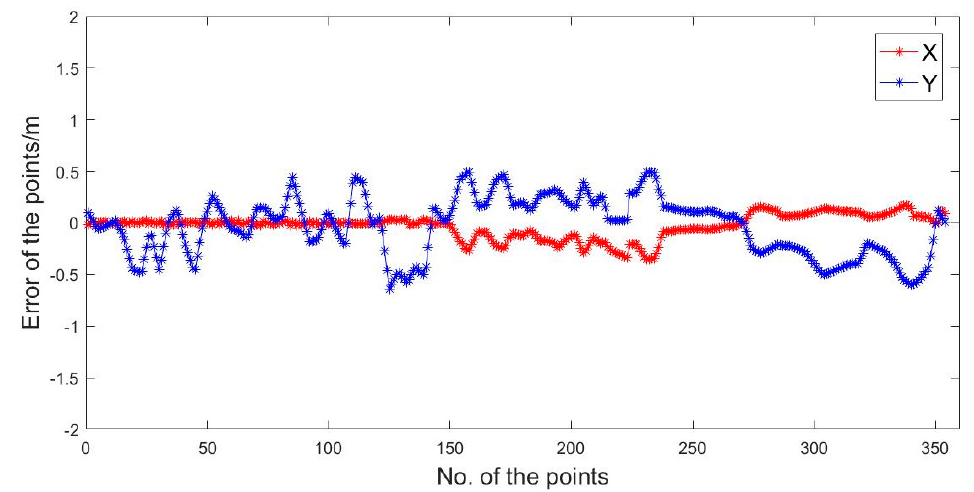
Figure 15. The UWB positioning errors.